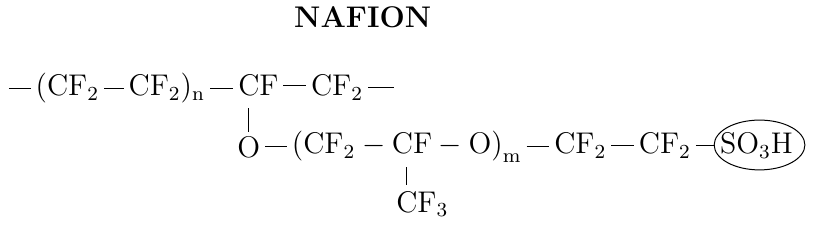
Figure 1. Nafion, a fluorocarbon backbone with SO standard PFSA